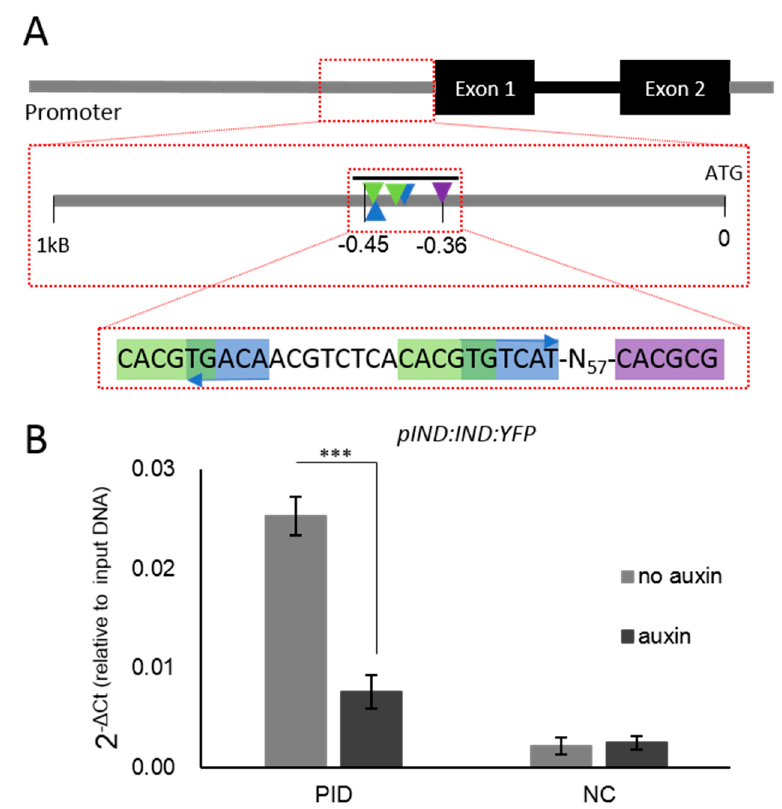
Figure 3. The transcription factors ETT and IND can bind to the complex regulatory patch within the PID promoter. ( A ) Schematic representation of the regulatory region. The black bar above the zoomed region indicates the amplicon used in qPCR reactions. Green indicates G-boxes; blue indicates AuxREs; purple indicates the E-box. ( B ) IND can bind to the regulatory patch. Auxin reduces IND binding to the PID promoter (*** p -Values < 0.0001; shown are the averages of three biological replicates ± standard deviation). NC, negative control.